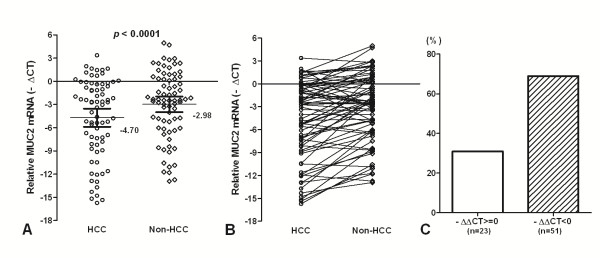
MUC2 mRNA in HCC and the matched non-tumor liver tissues. (A) The MUC2 mRNA was indicated in HCC and Non-HCC samples. Data are shown by the Mean -ΔCT and 95%CI. The MUC2 mRNA in HCC was lower than that in the matched non-tumor liver tissues (p < 0.0001). (B) There was a decreased tendency for MUC2 expression from Non-HCC tissues to HCC. (C) Expression of MUC2 was elevated (−ΔΔCt > =0) in only 23 of the 74 HCC patients but decreased (−ΔΔCt < 0) in 51 of the patients. Statistical analyses were done using the paired t test.